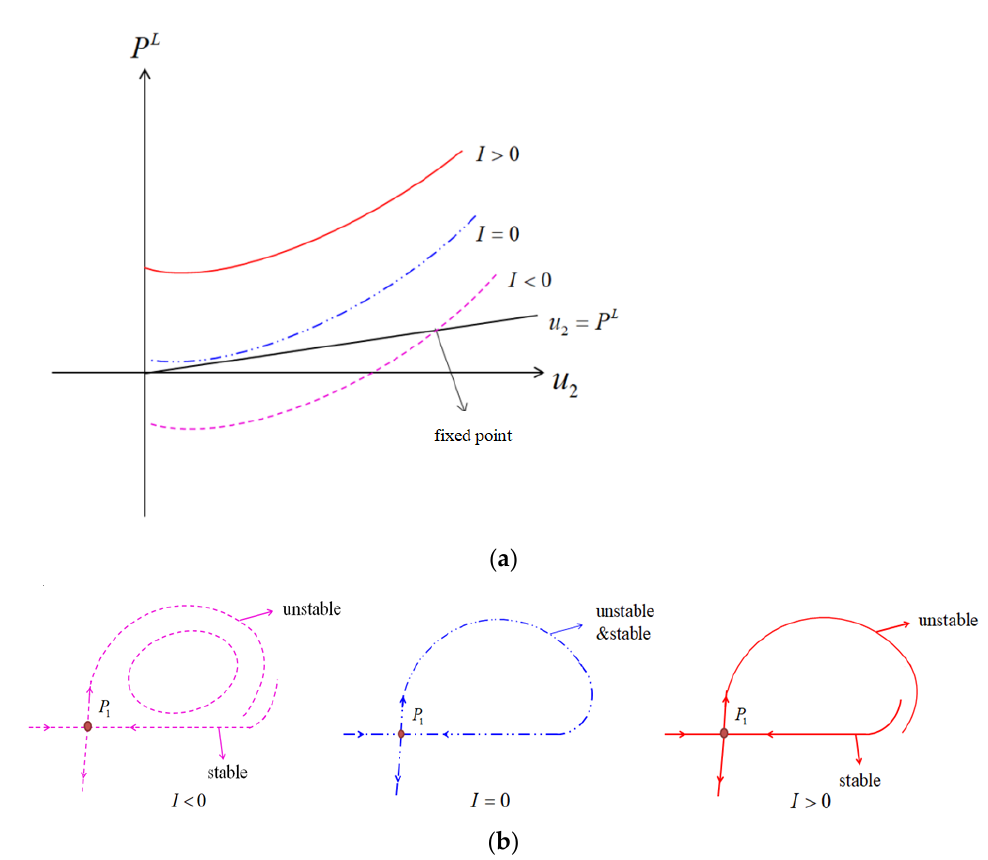
c < 1, ( a ) The fixed-point diagram. ( b ) The Positional c 2 1  , ( a ) The fixed-point diagram. ( b ) The Positional c 2